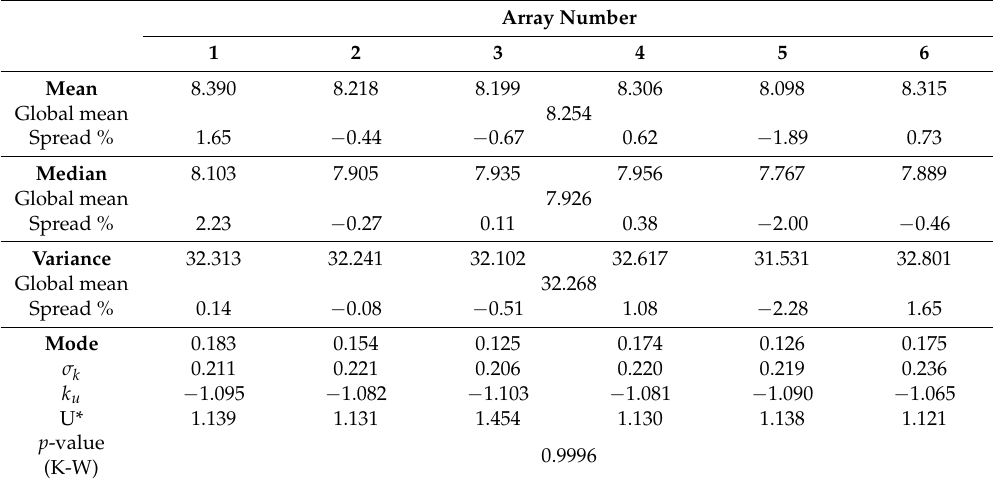
Table 2. Mean, median, and variance of the daily energy (in kWh) produced by each array and relative spreads for three months. Skewness, kurtosis and p